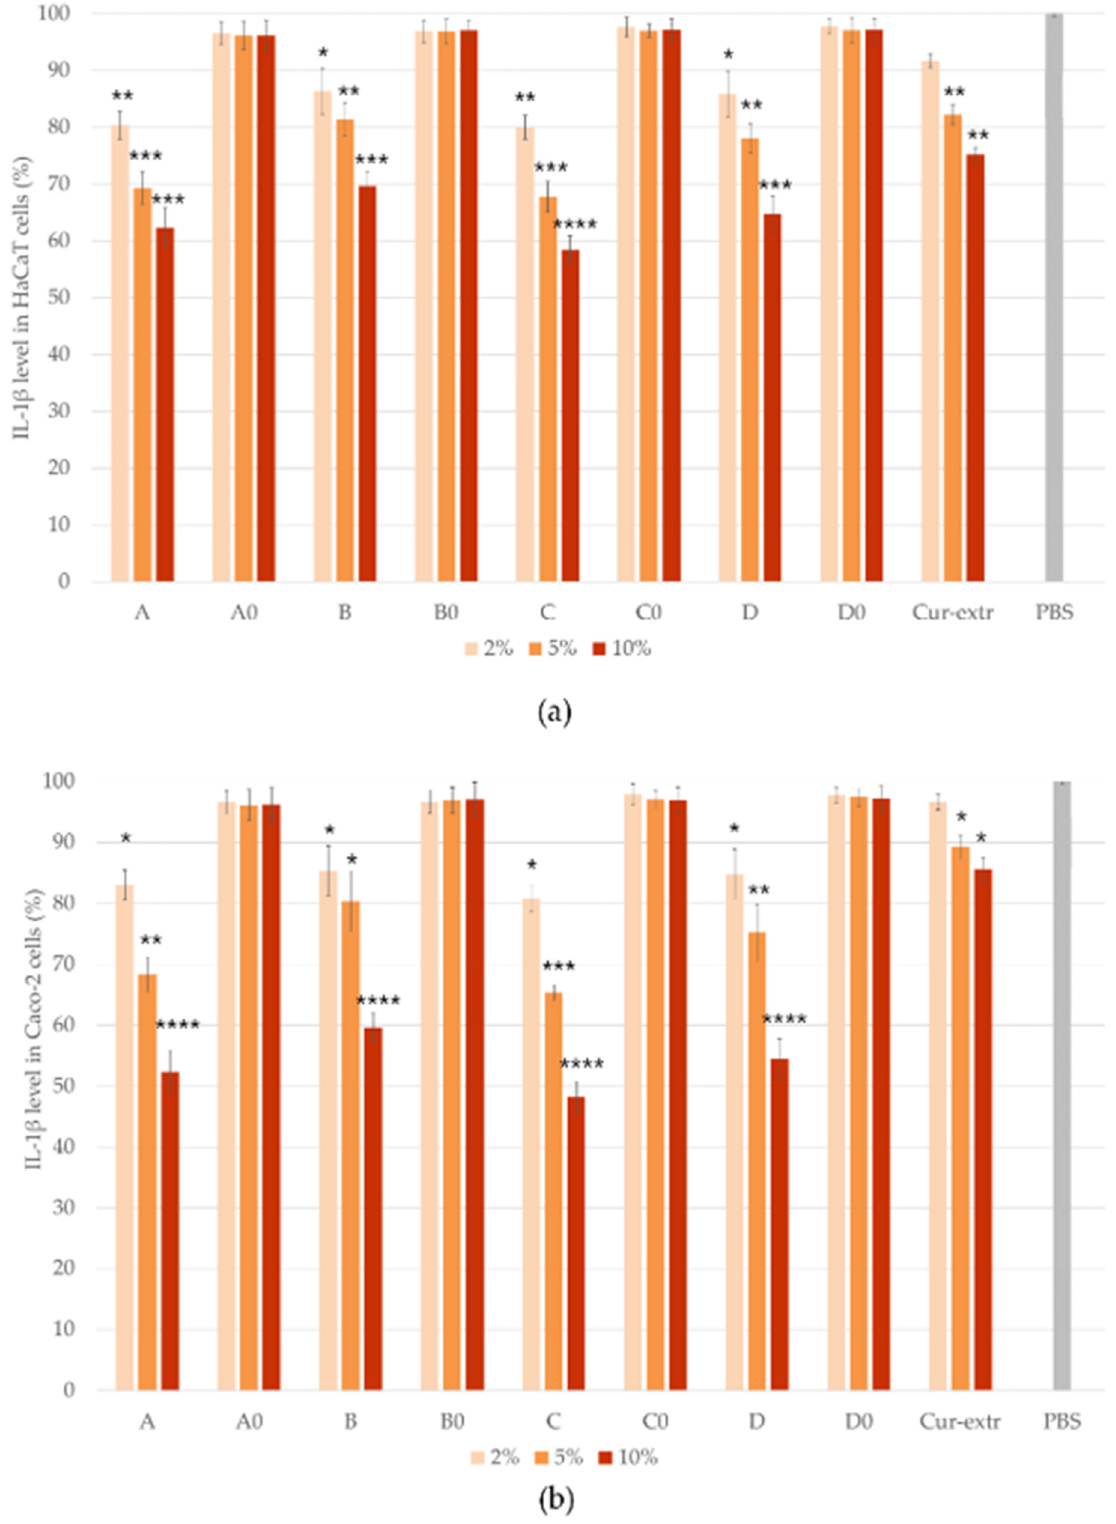
Figure 9. Results of human IL-1 β ELISA tests on HaCaT ( a ) and Caco-2 ( b ) cells. Data represent the mean of six wells ± SD. Data are expressed as means ± SD, n = 6. Ordinary one-way ANOVA with Dunnett’s multiple comparison test was performed to compare the different formulations with PBS. The *, **, ***, and **** indicate statistically significant differences at p < 0.05, p < 0.01, p < 0.001, and p < 0.0001.